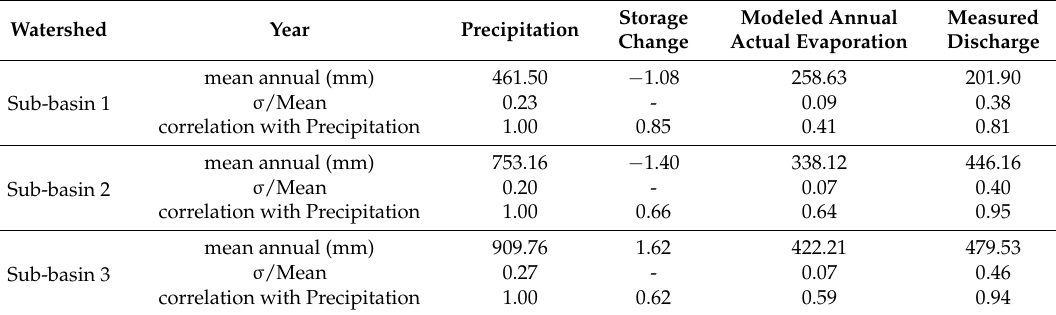
Table 5. The water balance components of the three